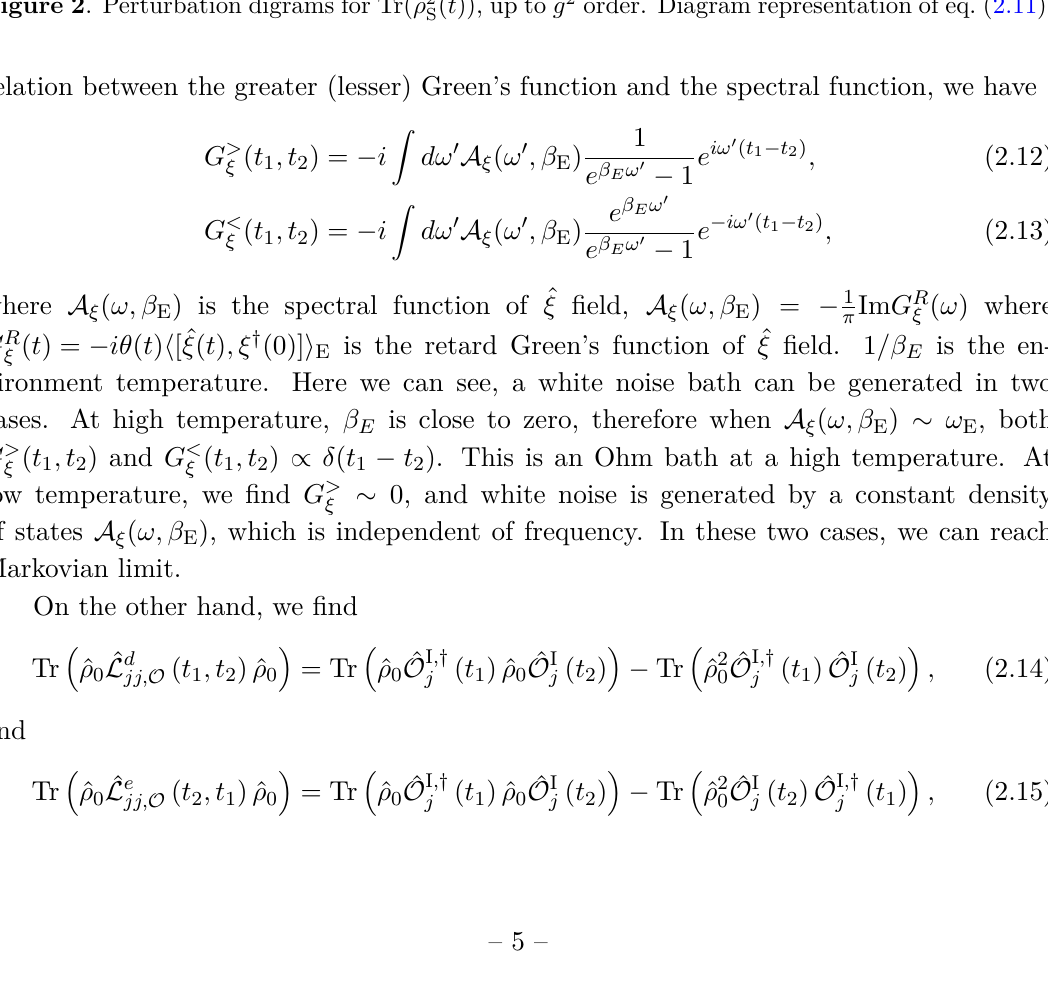
Figure 2 . Perturbation digrams for Tr(ˆ ρ 2